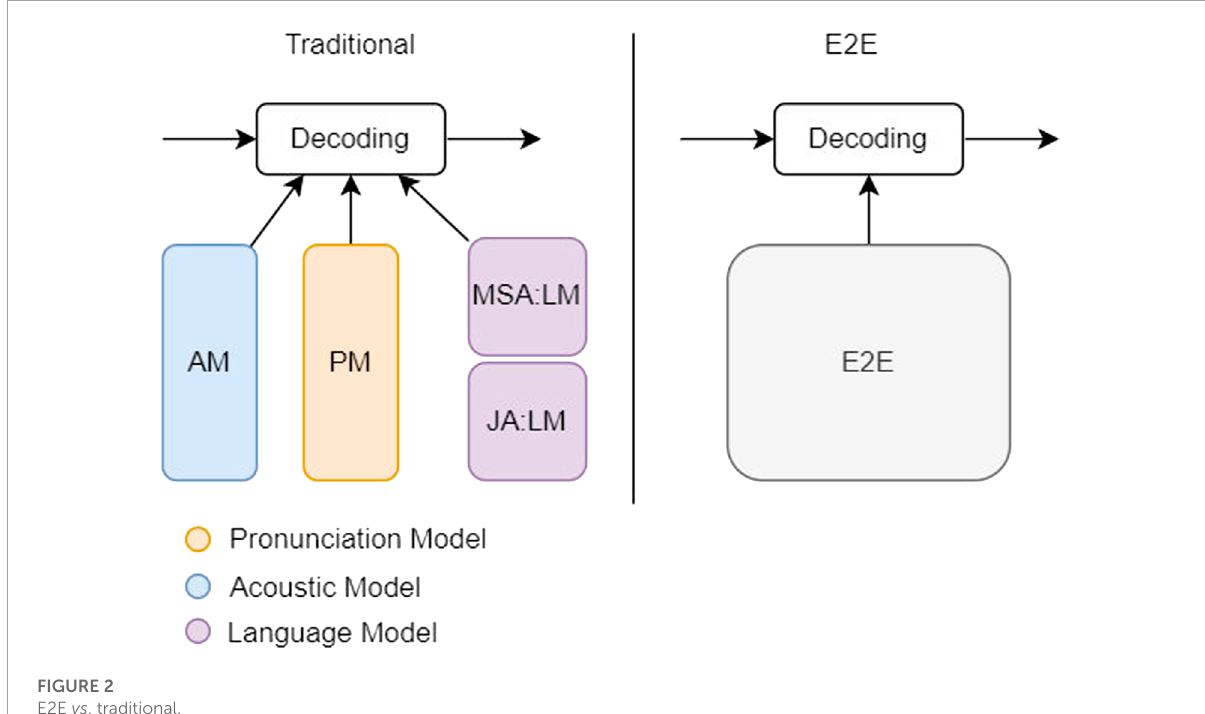
FIGURE 2 E2E vs .